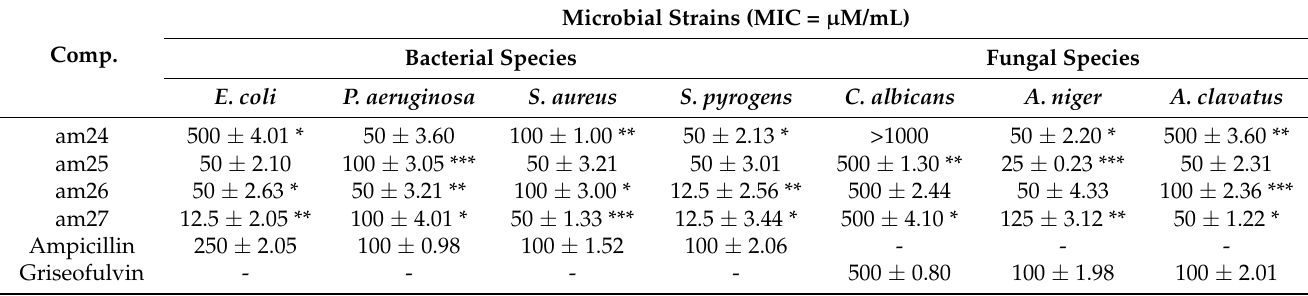
Table 12. Results of antimicrobial screening of the synthesized compounds ( am24 – am27 ).